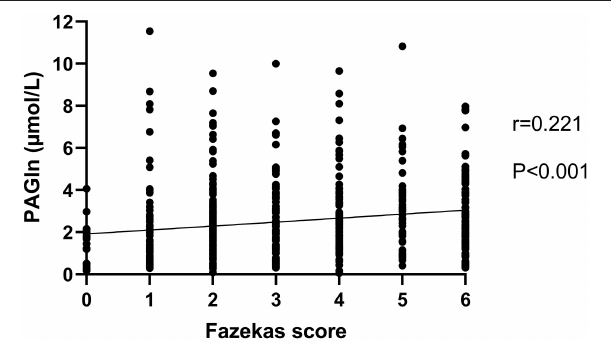
FIGURE 2 | Correlation between PAGln levels and Fazekas score. PAGln levels showed a significant, although limited, relationship with the total Fazekas score ( r = 0.221, P < 0.001, and Spearman rank correlation analysis). PAGln, phenylacetylglutamine.